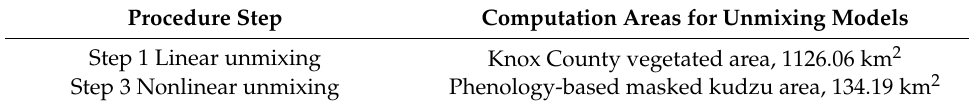
Table 4. Computation areas for linear and nonlinear unmixing models.